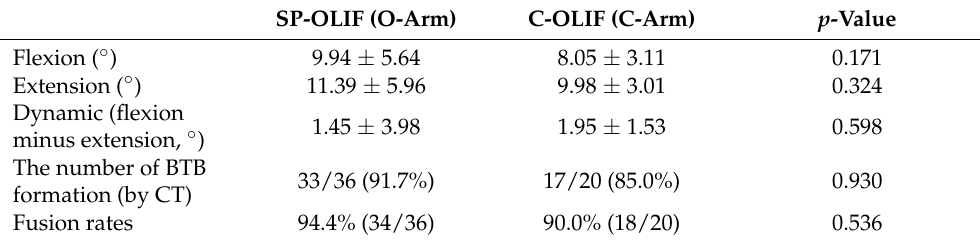
Table 4. Radiologic outcomes.